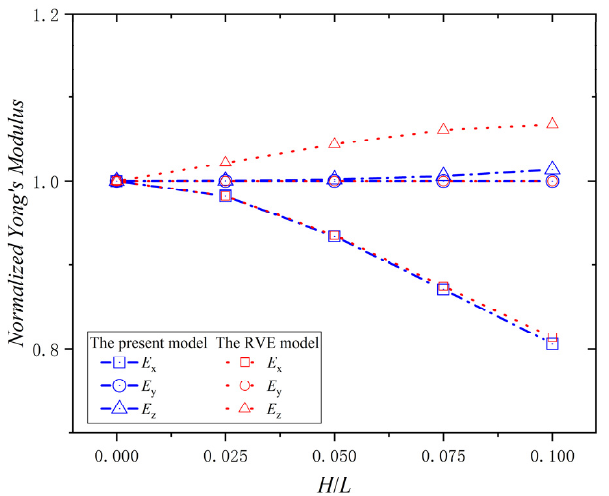
Figure 10. Normalized Young’s modulus vs. ply wrinkle parameter 𝐻 / 𝐿; 𝜑 = 45°.